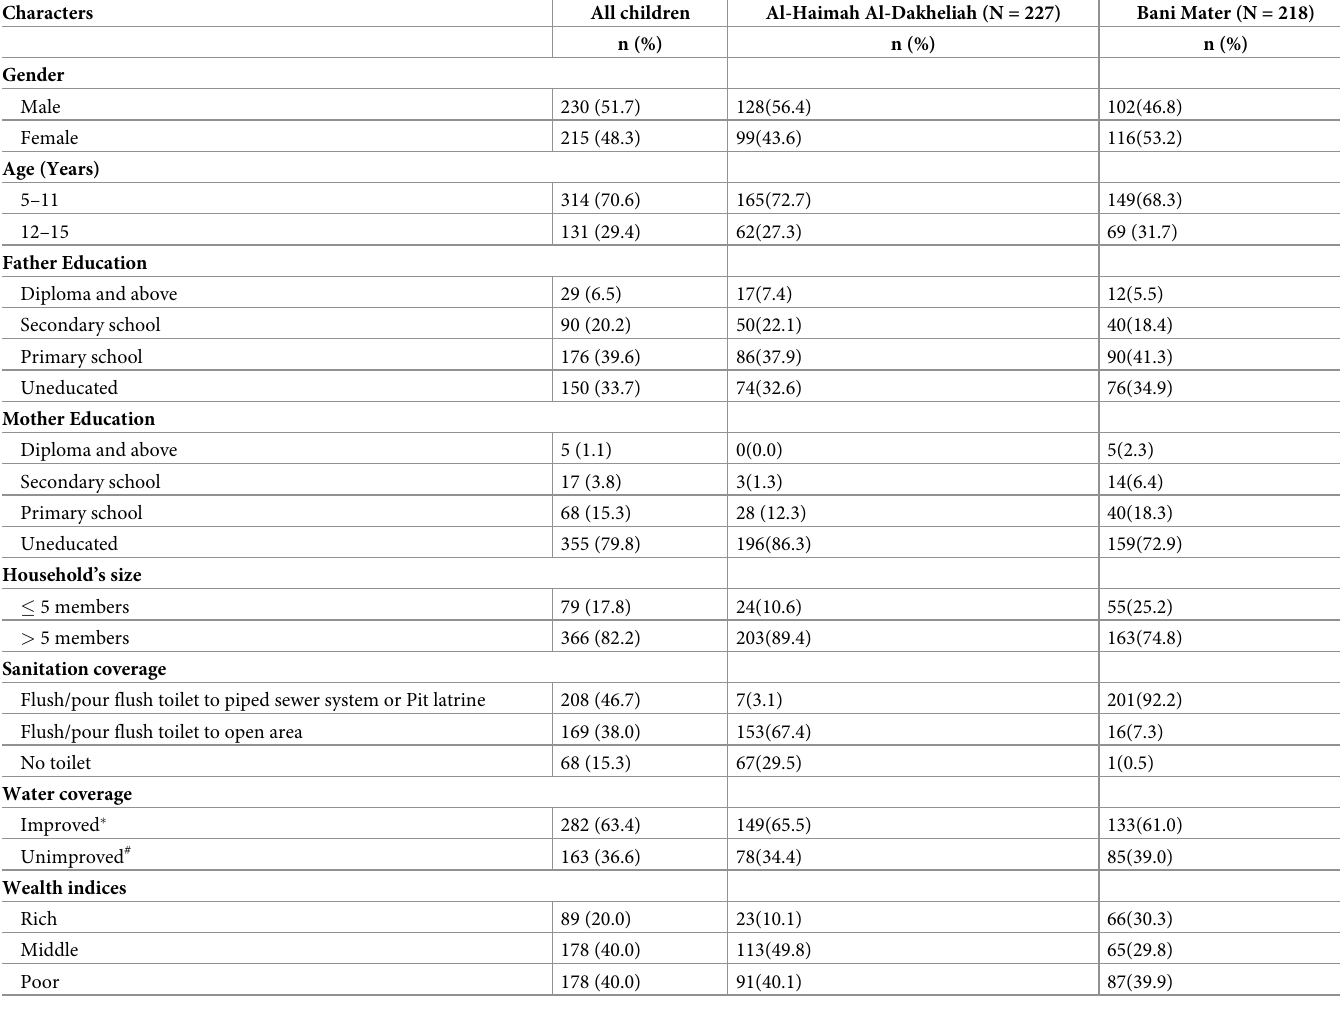
Table 1. Distribution of the study population by socio-demographic information, Sana’a Governorate,